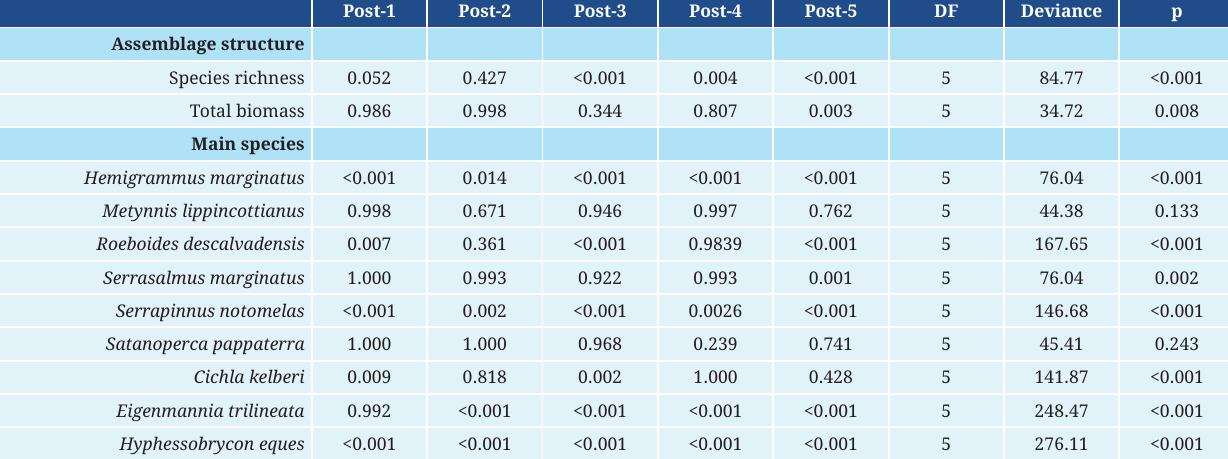
TABLE 2 | GLM results contrasting Pre and Post periods, considering the structure of fish assemblages (species richness, total biomass), main species and ecosystem functions (trait-states). A post-hoc linear test contrasted the Pre period with each Post-period (p